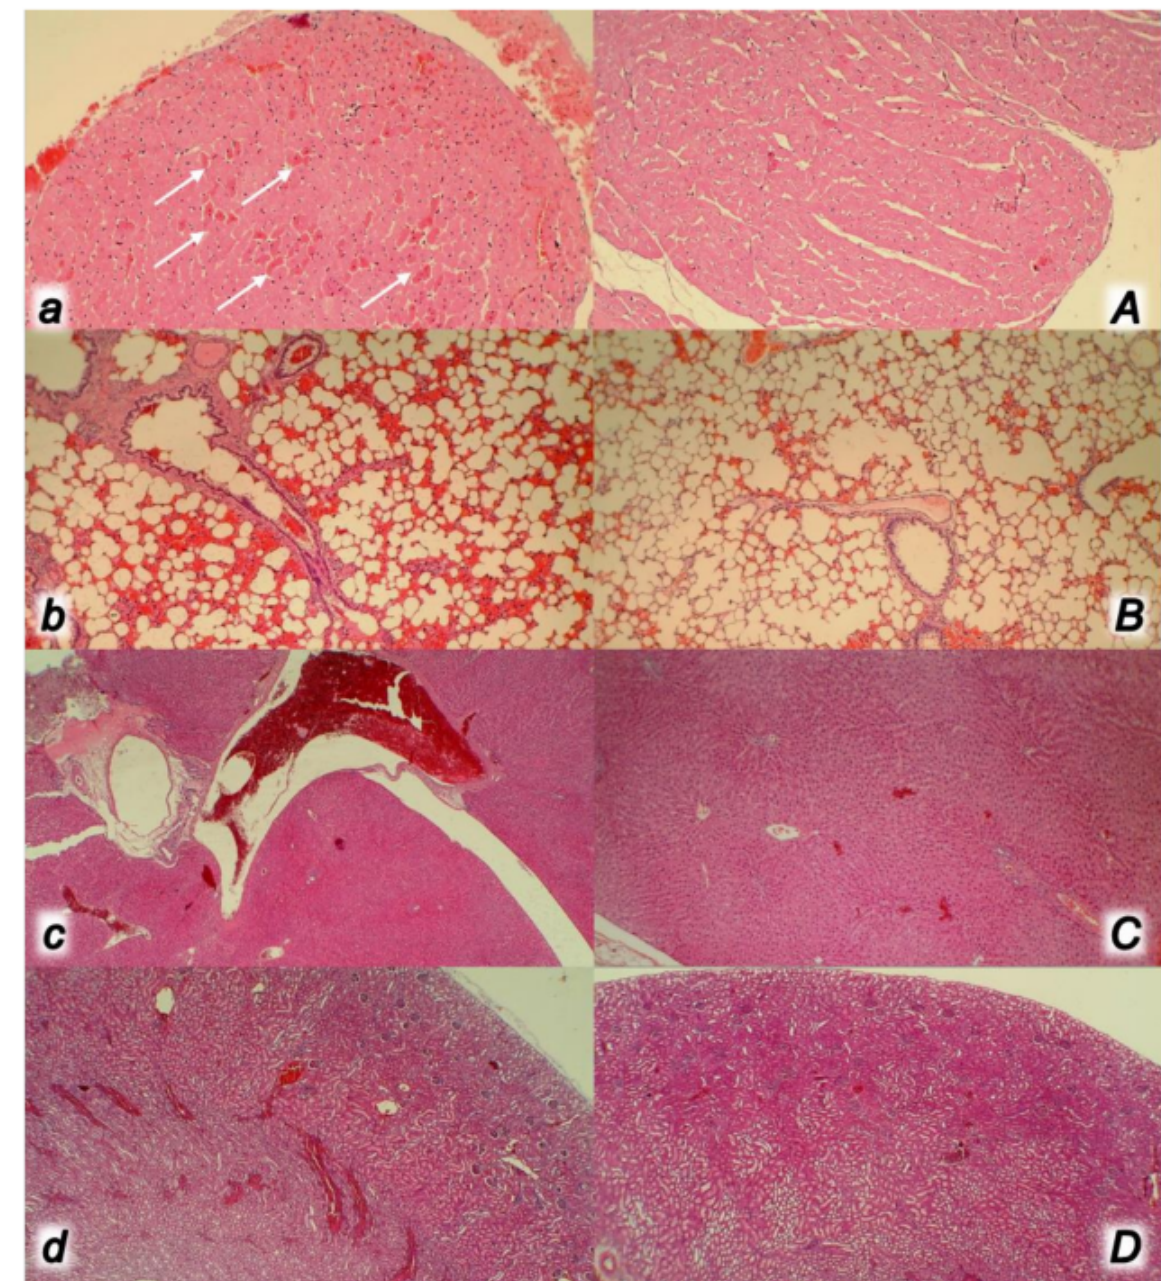
Figure 12. At 30 min ligation-time, microscopy presentation of the congestion of the heart ( a , A ) (HE, × 200), lung ( b , B ) (HE, × 100), liver ( c , C ) (HE, × 100), and the renal parenchyma ( d , D ) (HE, × 100) in the rats with occluded superior mesenteric vein and artery, controls (small letters) and BPC 157 treated (capitals). Control rats with occluded superior mesenteric vein and artery exhibited the subendocardial infarct as well as congestion within the myocardium ( a ) and lung septa along with intra-alveolar hemorrhage ( b ), liver congestion and dilatation of sinusoids, portal vein, and central veins ( c ) along with congestion of renal parenchyma and glomeruli ( d ). BPC 157 treated rats showed no heart congestion and heart infarct ( A ) along with minimal lung congestion and intra-alveolar hemorrhage ( B ) and no changes in the liver ( C ) and renal parenchyma ( D